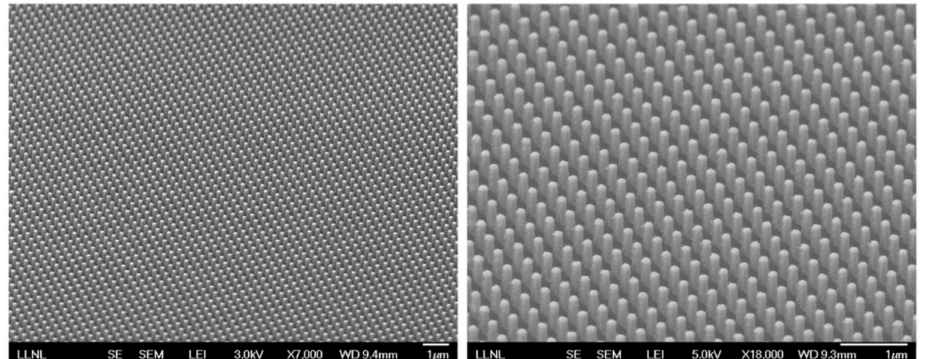
Figure 3. SEM images of the Ag-coated nanopillar arrays patterned on the fiber core (tilted view: 45 ◦ ) using IL. Reprinted with permission from Ref. [52]. Copyright 2012 Optica Publishing